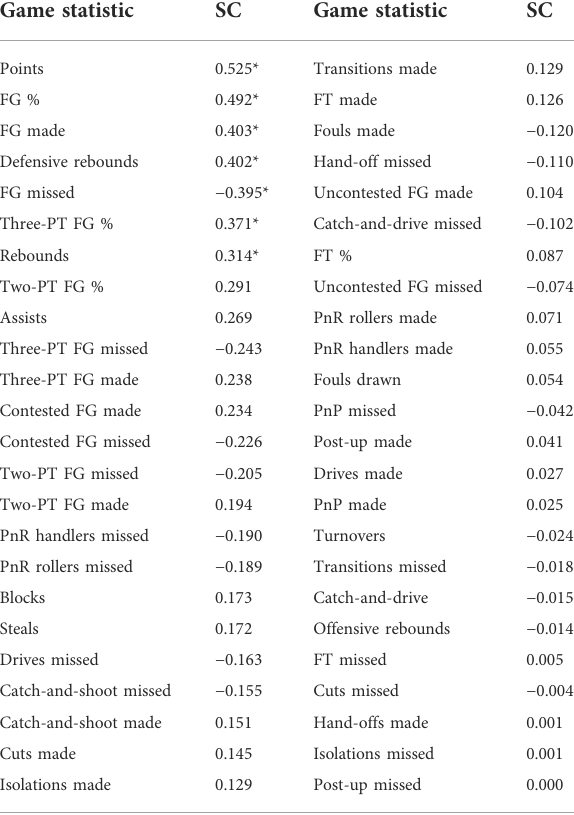
TABLE5Discriminantfunctionstructurecoef fi cients(SCs)andtestsof statistical signi fi cance. Game